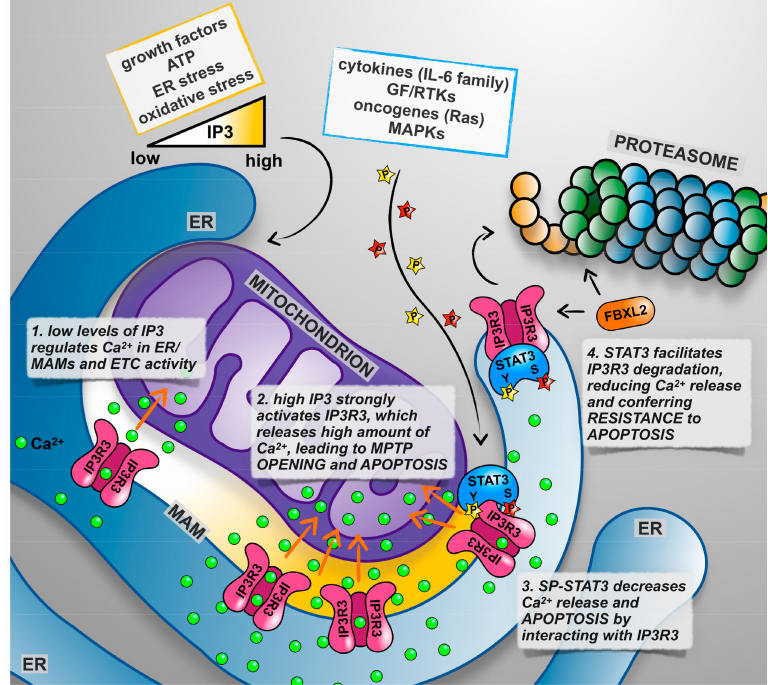
Figure 2. STAT3 role in the endoplasmic reticulum (ER). See text for details and